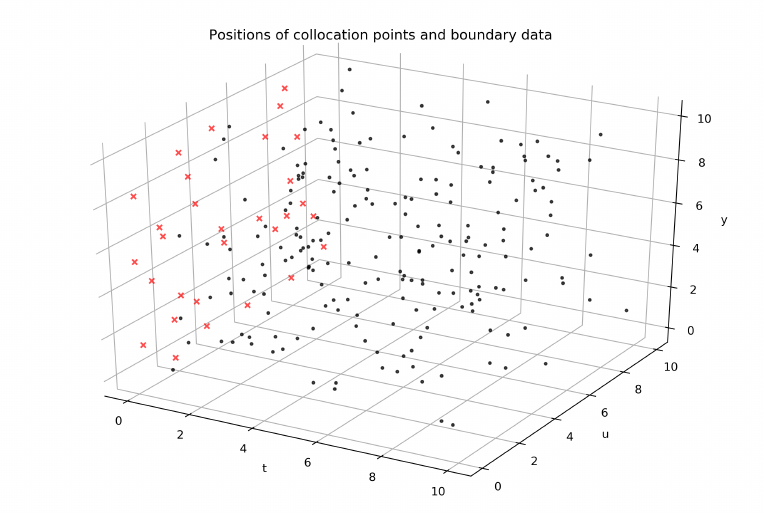
Figure 8. The randomly selected data points used to construct the training data